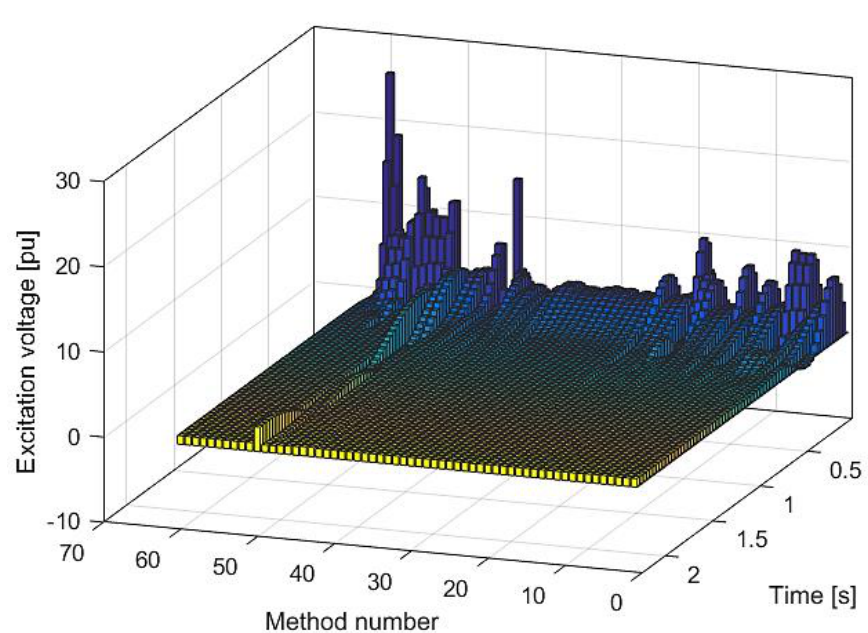
Figure 7. Generator voltage responses of the AVR system via different PID parameters.